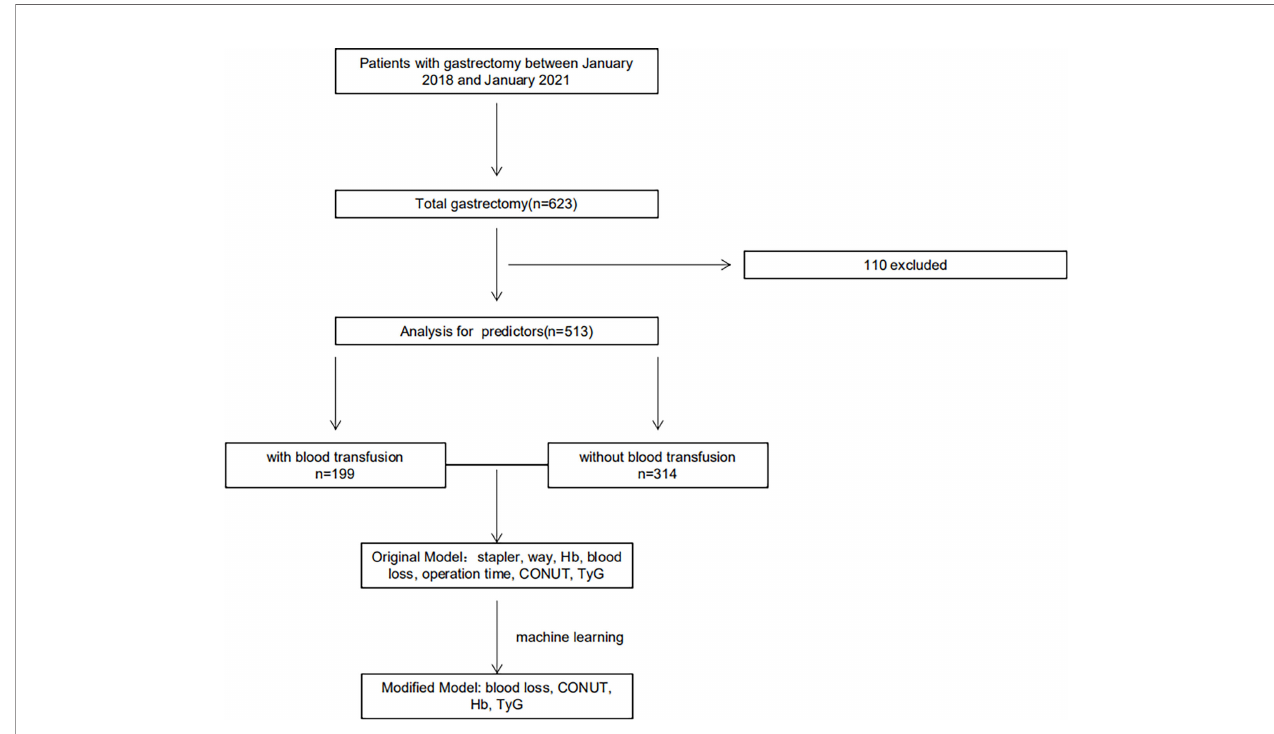
FIGURE 1 | Flowchart of the study. A total of 513 patients were included in the fi nal study for perioperative transfusion-related